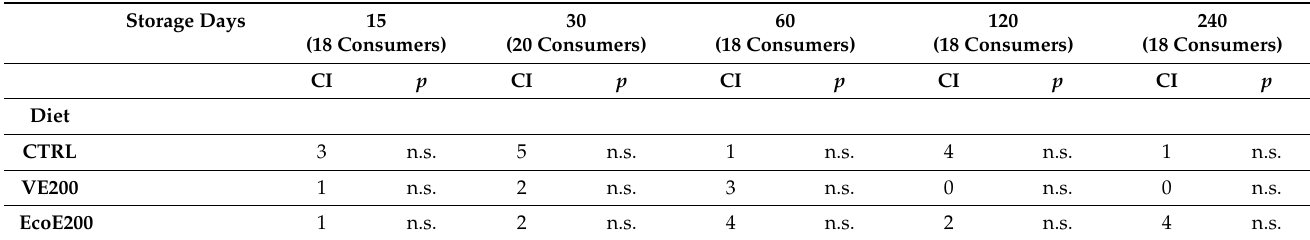
Table 6. Diet supplementation discriminability via triangle test. Number of correct identifications (CI) of diet are